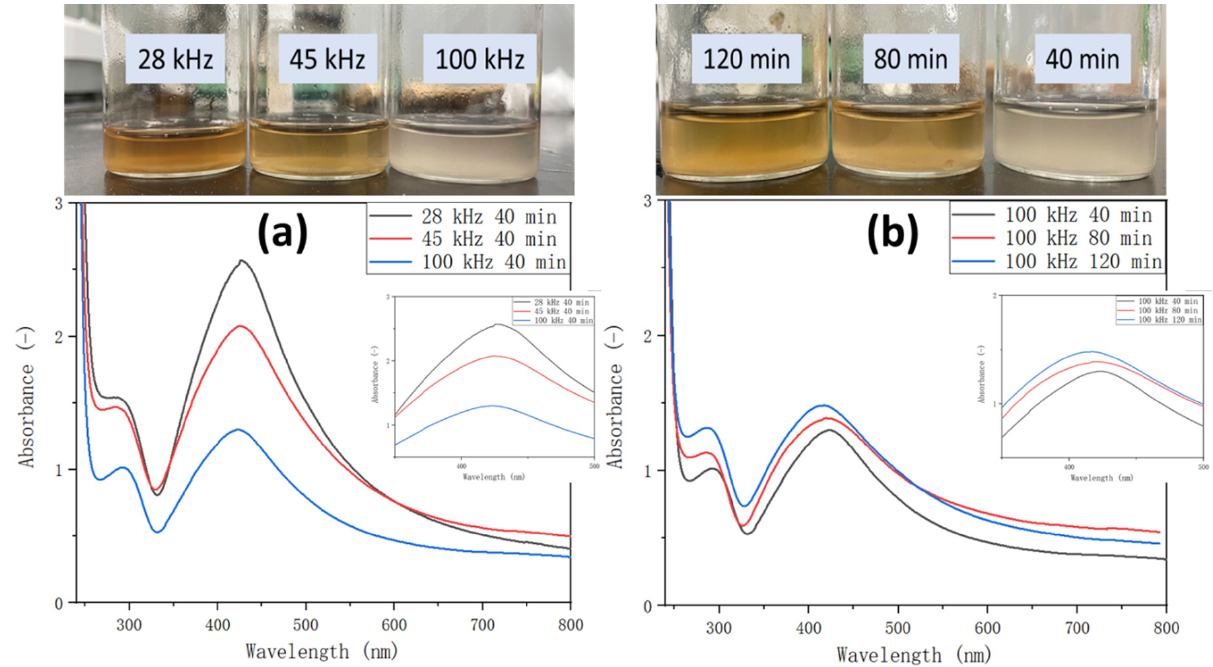
Figure 3. ( a ) UV spectra of the colloidal Ag NP solutions produced through ultrasonic irradiation at different frequencies (28, 45, and 100 kHz) for 40 min sonication duration, and ( b ) different ultrasonic times (40, 80, and 120 min) at frequency of 100 kHz.